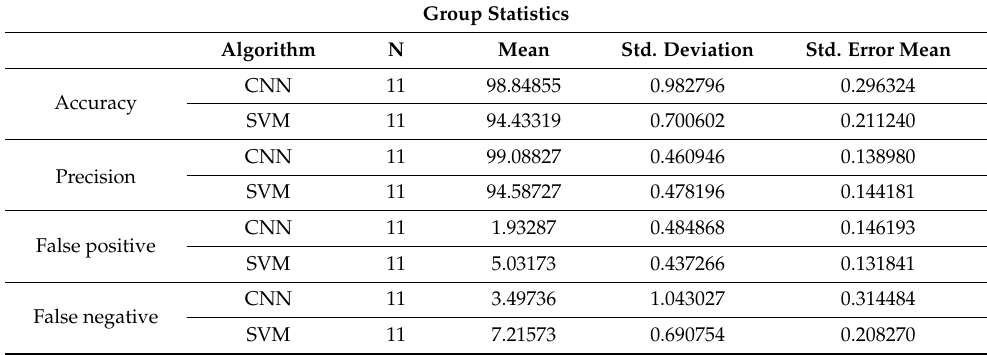
Table 8. Group statistics comparison of the CNN and SVM algorithms for performance measures.